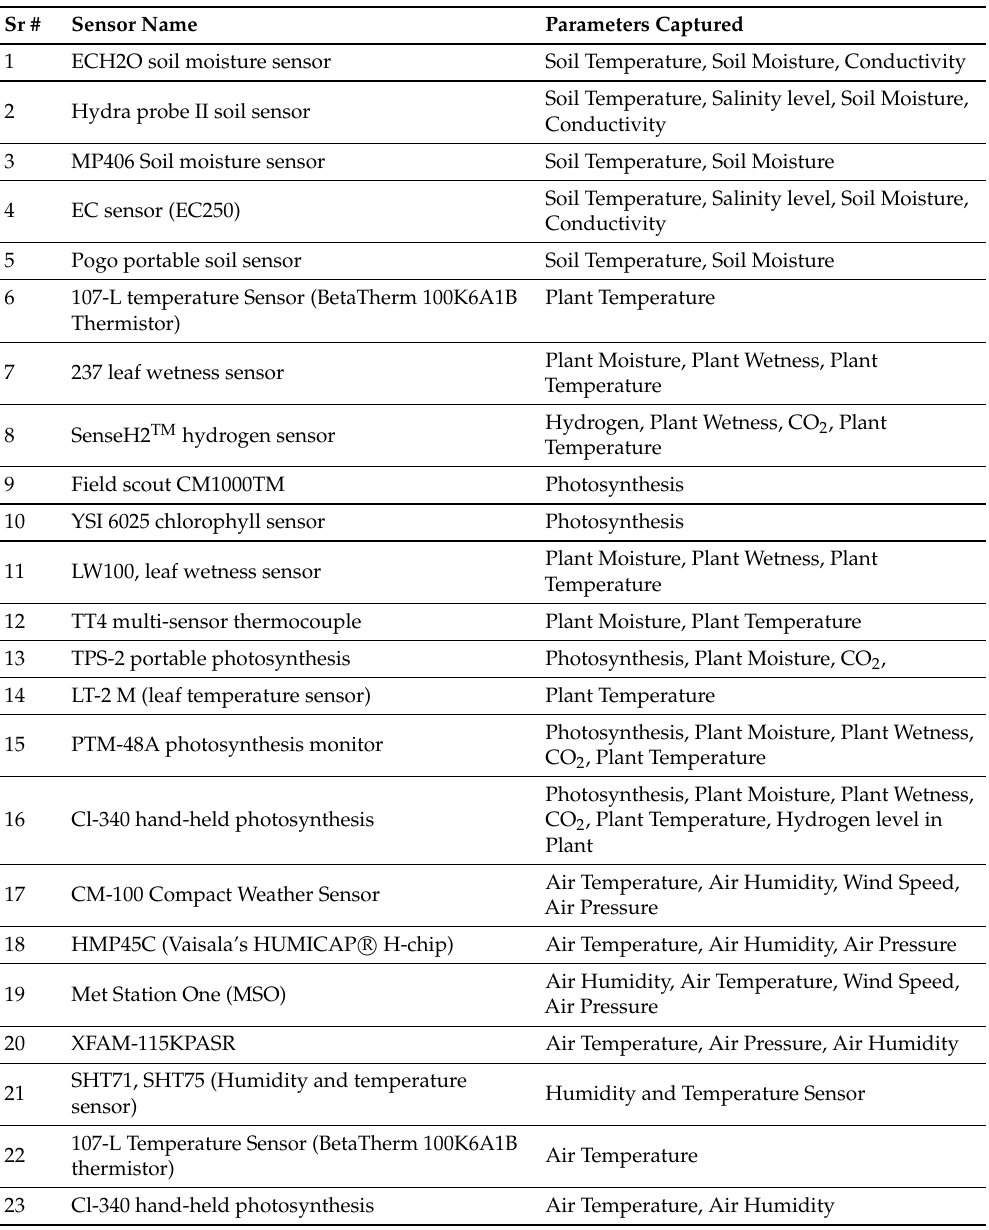
Table 1. Wireless nodes used in the agriculture